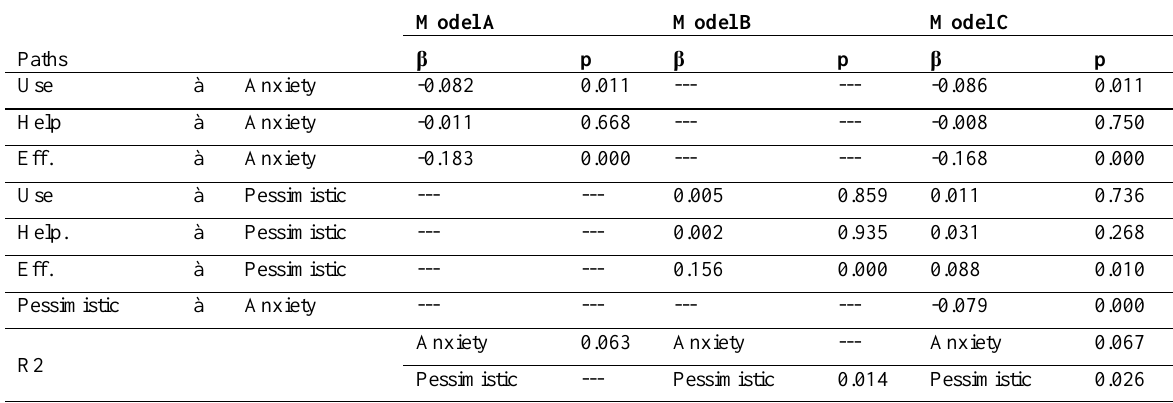
Table 5: The mediating role of